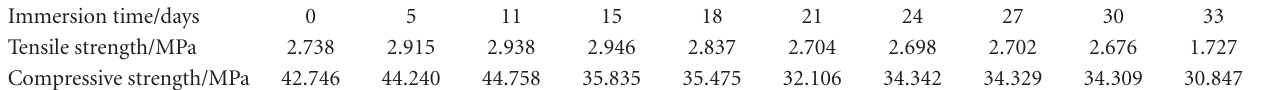
Figure 8: Typical fracture area of concrete in di ff erent corrosion period. Table 3: Strength of concrete exposed to acid solution for di ff erent periods.